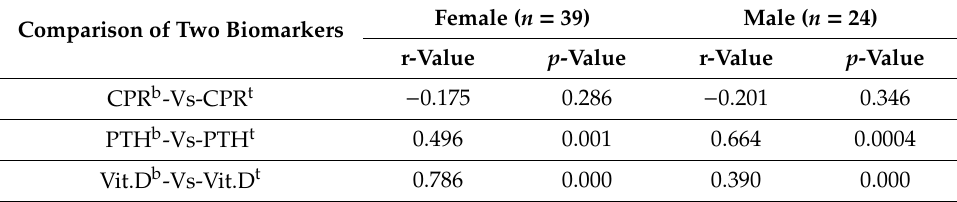
Table 2. Analysis of correlation coe ffi cients of biomarkers between baseline and end of eight-week treatment with